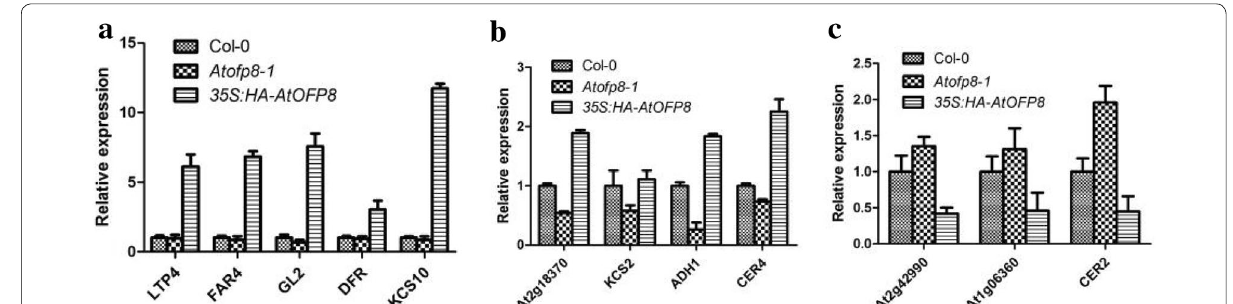
Fig. 6 Expression of genes that relate to waxes in Arabidopsis ( a , b , c ). The leaves of 3 weeks old plants were used. Bars indicate SE of the mean